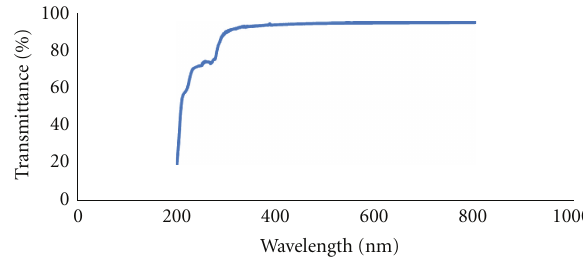
Figure 2: The curve diagram of PDMS transmittance.